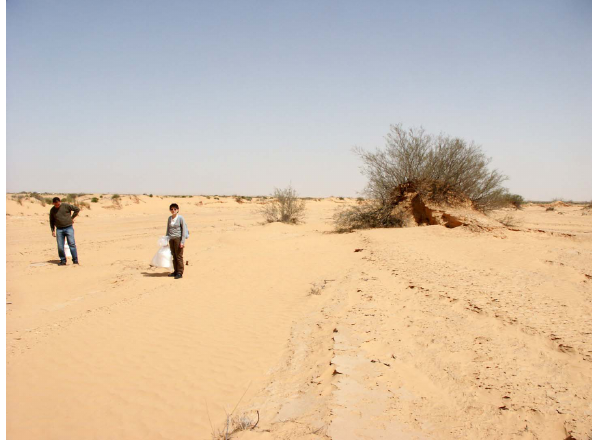
Fig. 4. Photo of the soil sampling area in the dry bed of Oued El Figure 4 Hallouf. In the centre of the front plan are visible clearer rests of clay deposits uncovered by the more orange sand (photo F. Dulac).